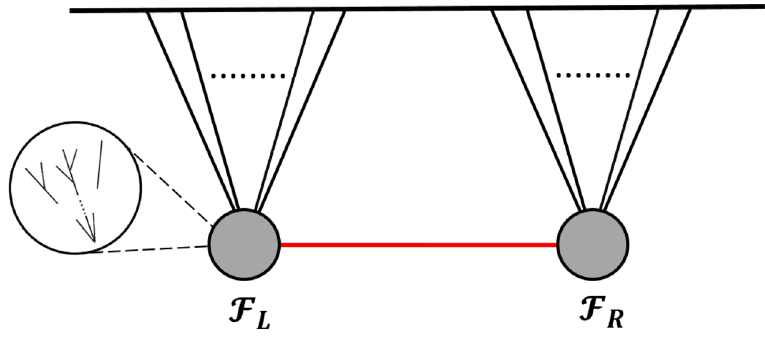
Figure 3 . A general tree level diagram. The red line is the massive propagator and other black lines are massless. The left and right blobs may have their own substructure and we collect it into F L and F R